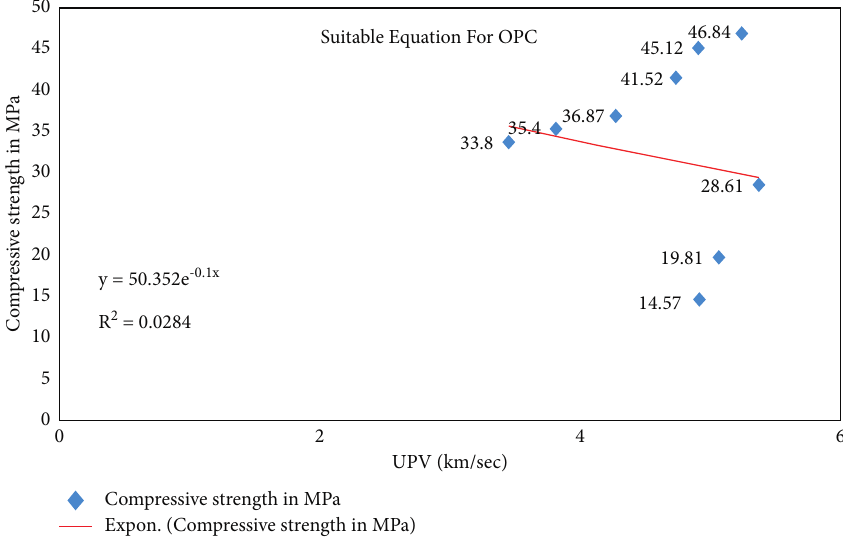
Figure 11: Equation obtained for